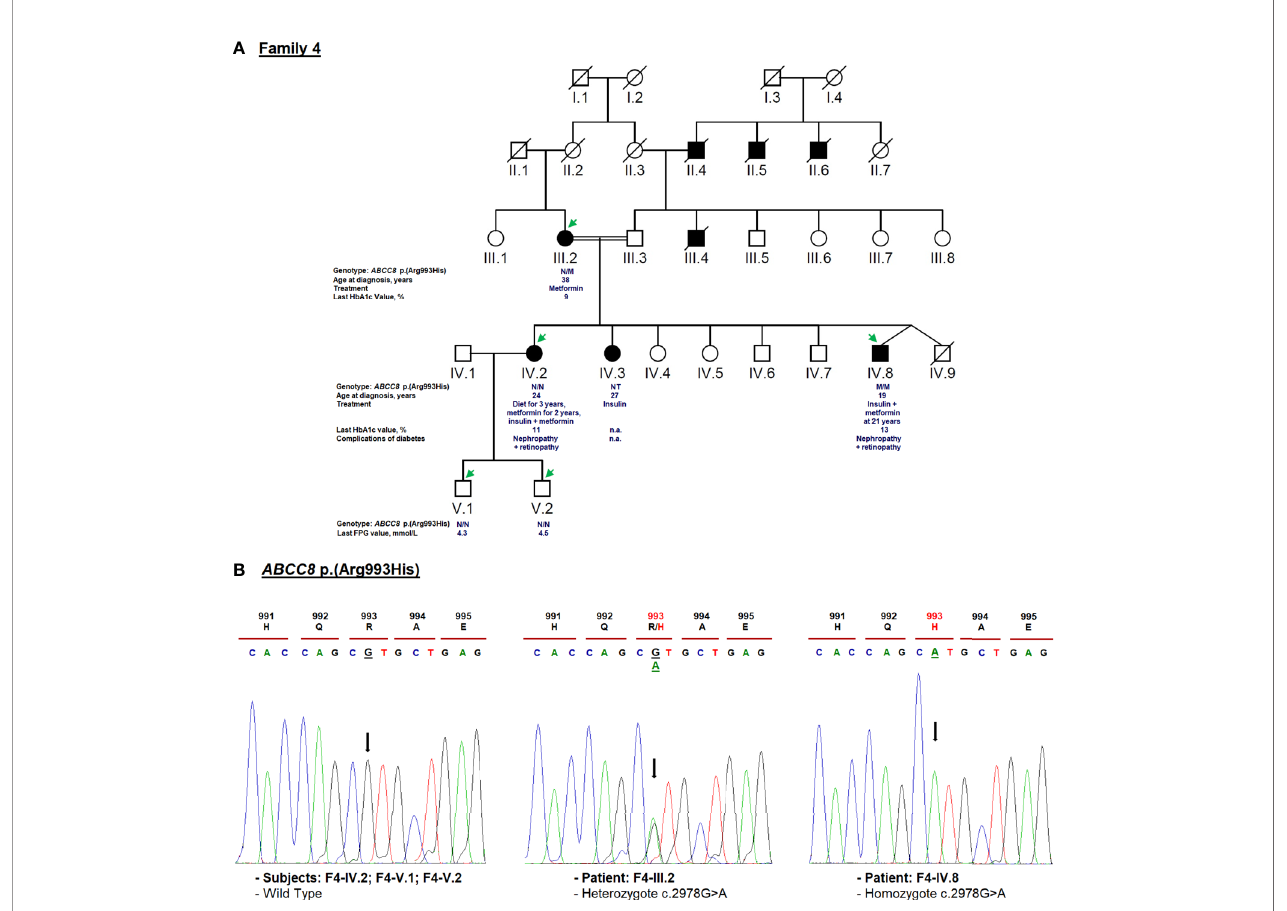
FIGURE 5 | Mutation analysis of the ABCC8 gene. Panel (A) Pedigree of the family F4 identi fi ed with ABCC8 variant [NM_001287174.2: c.2978G>A, p.(Arg993His)]. FPG, fasting plasma glucose; NT, not tested; n.a, Not available. M and N denote mutant and wild-type alleles, respectively. The age of diabetes onset, glycemic control (the latest FPG or HbA1c measurements), complications of diabetes, and treatment follow-up are indicated directly below the genotype. Panel (B) Validation of the ABCC8 c.2978G>A variant segregation by Sanger sequencing. Mutated nucleotide on the chromatographs is depicted with an arrow. Amino acid substitution is indicated in